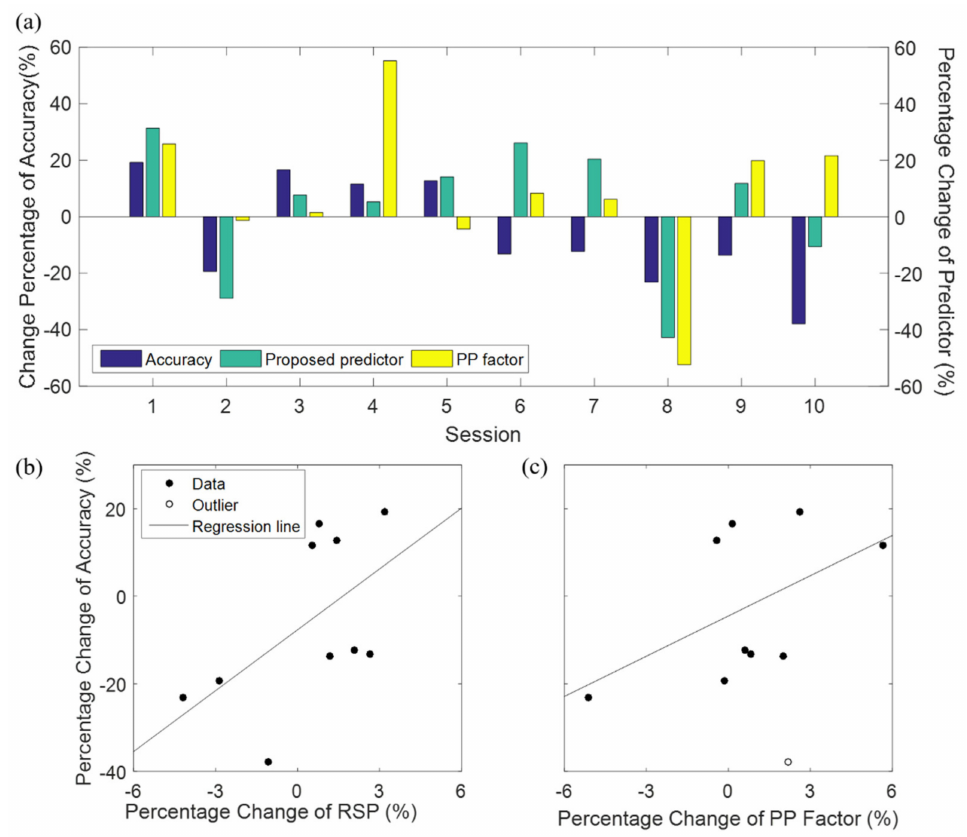
Figure 6. ( a ) Comparison between percentage change in BCI classification accuracy and percentage change in prediction value. ( b ) Our proposed predictor (RSP) and ( c ) the PP factor for session variabillity. Blank markers indicate